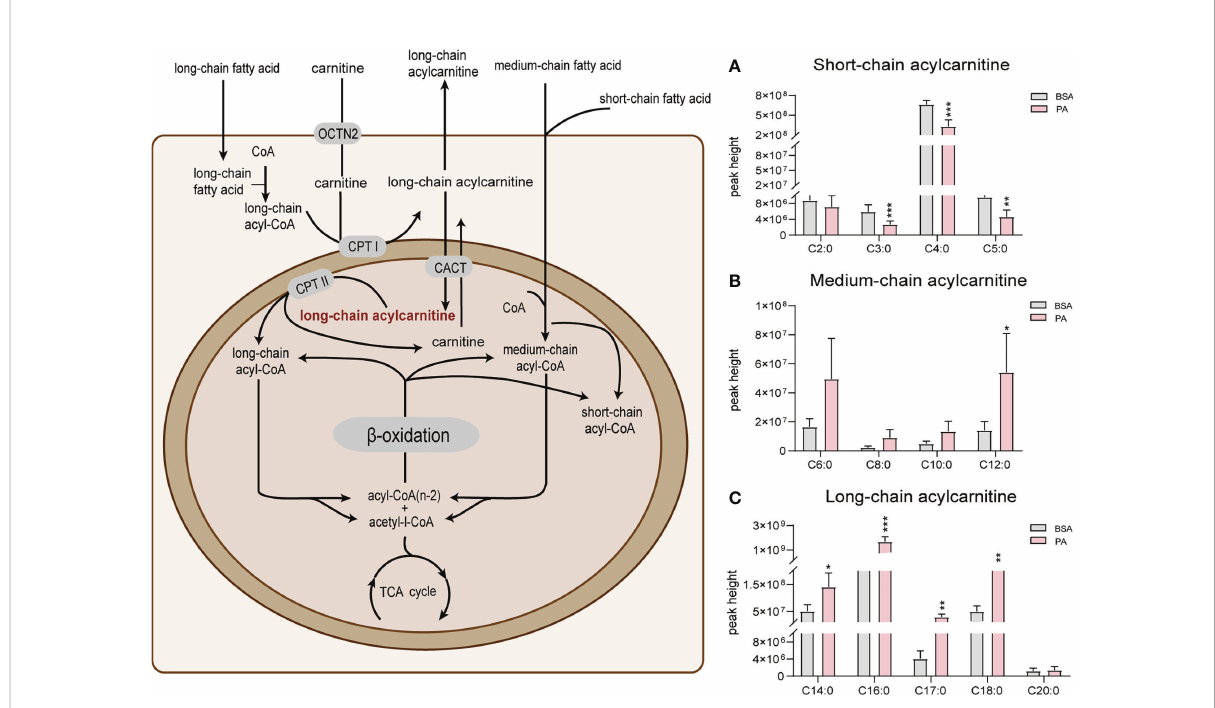
FIGURE 3 Effect of PA on acylcarnitines in SCs. The schematic diagram of fatty acid b -oxidation in SCs is shown on the left. Free carnitine in plasma enters cells through organic cation/carnitine transporter 2 (OCTN2). Long-chain fatty acids then enter the mitochondria with the help of carnitine and are transformed into acylcarnitines by carnitine palmitoyltransferase 1 (CPT1), which is located in the outer membrane of mitochondria. Acylcarnitines then pass through the inner mitochondrial membrane (IMM) through carnitine acyltransferase (CACT) to exchange free carnitine. Carnitine palmitoyltransferases 2 (CPT 2), which is located in the IMM, converts acylcarnitines into acyl-CoA and free L-carnitine for the next oxidation reaction. Medium- and short-chain fatty acids do not require carnitine to enter mitochondria for oxidation. Subsequently, acylcarnitines are oxidized in the form of acyl coenzyme A (acyl-CoA) by a series of enzymes to produce acyl-CoA with two less carbon atoms than the original and acetyl-CoA, which is fi nally oxidized by the TCA cycle to produce CO 2 and H ₂ O as well as to release energy. The changes in long-, medium- and short-chain acylcarnitines are shown in panels A – C , respectively. Data were expressed as mean ± SD, *p < 0.05, **p < 0.01, ***p <